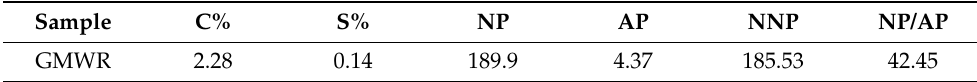
Table 2. Test acid–base accounting (ABA) of GMWR